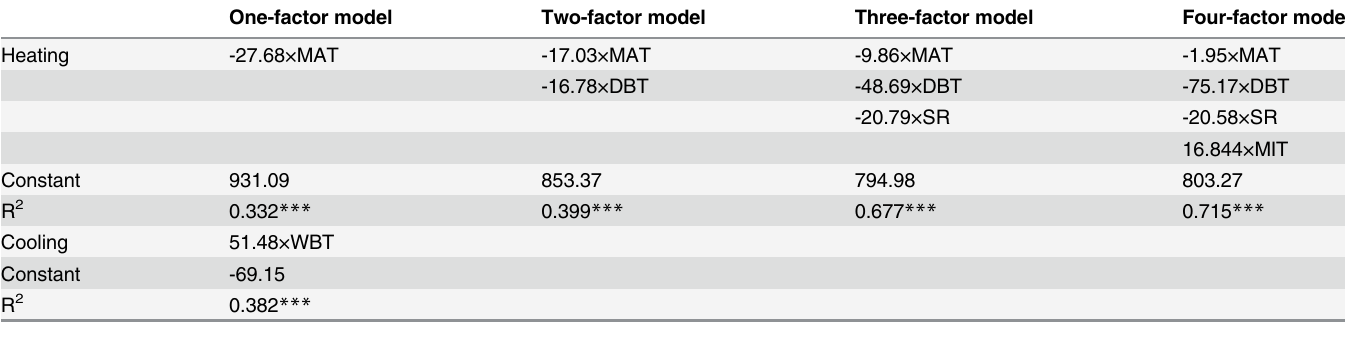
Table 3. Regression analysis for daily extreme energy consumption of commercial building against the climatic